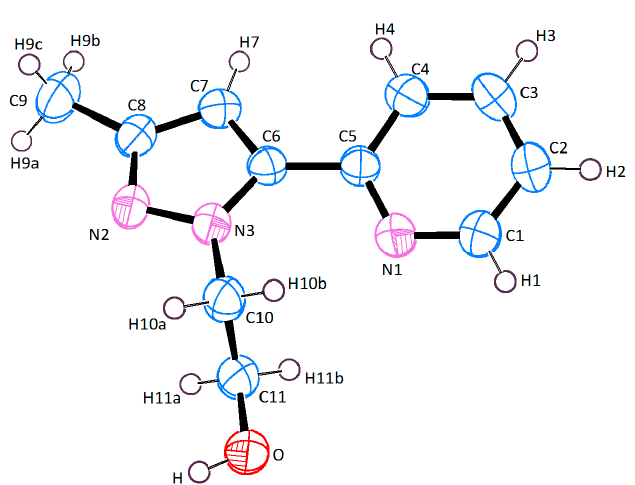
Figure 1. Asymmetric unit of C 11 H 13 N 3 O.